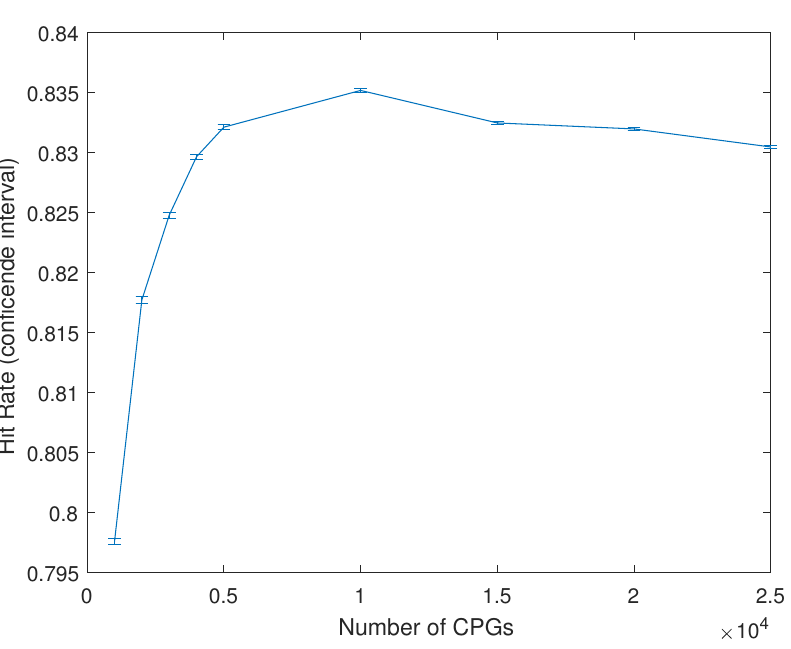
Figure 2. Average Hit Rate (HR) and confidence interval (5%) versus number of CpGs included in the analysis.